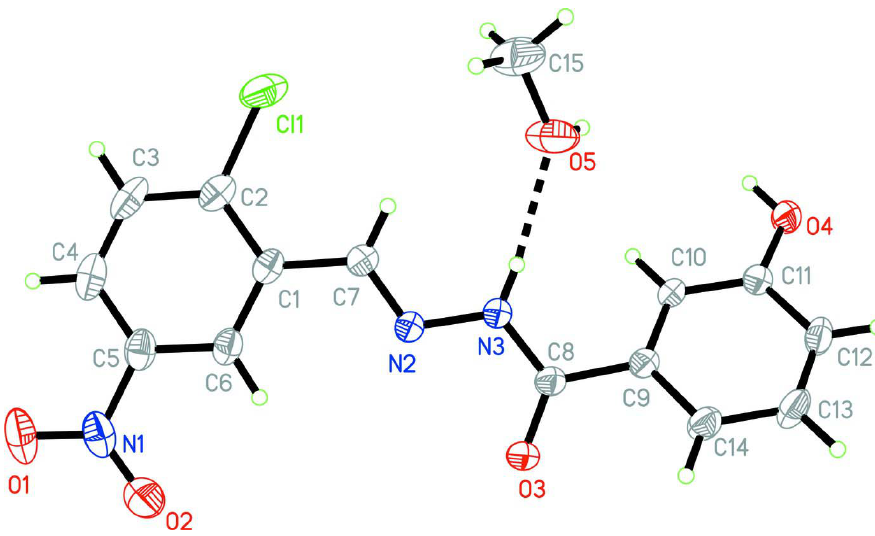
Figure 1 The molecular structure of the title compound, with displacement ellipsoids drawn at the 30% probability level. Hydrogen bond is shown as a dashed